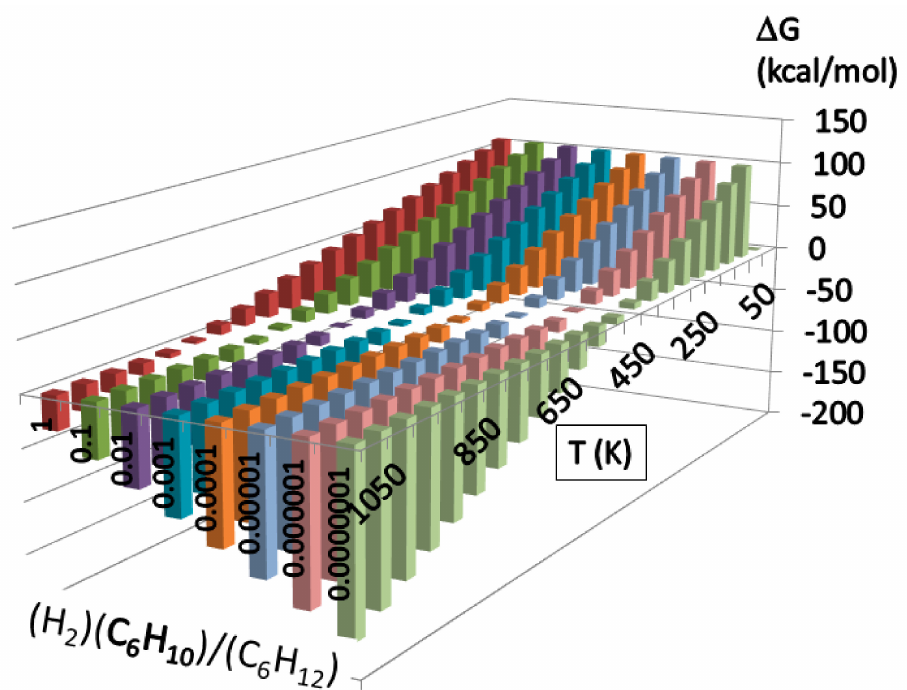
Figure 2. Free energy of dehydrogenation of cyclohexane (in kcal/mol) as a function of temperature and reaction quotient. Note that there are regions of pressure and temperature space, e.g., high temperature and low H 2 partial pressure, for which the overall reaction is spontaneous, as revealed by a negative free energy of